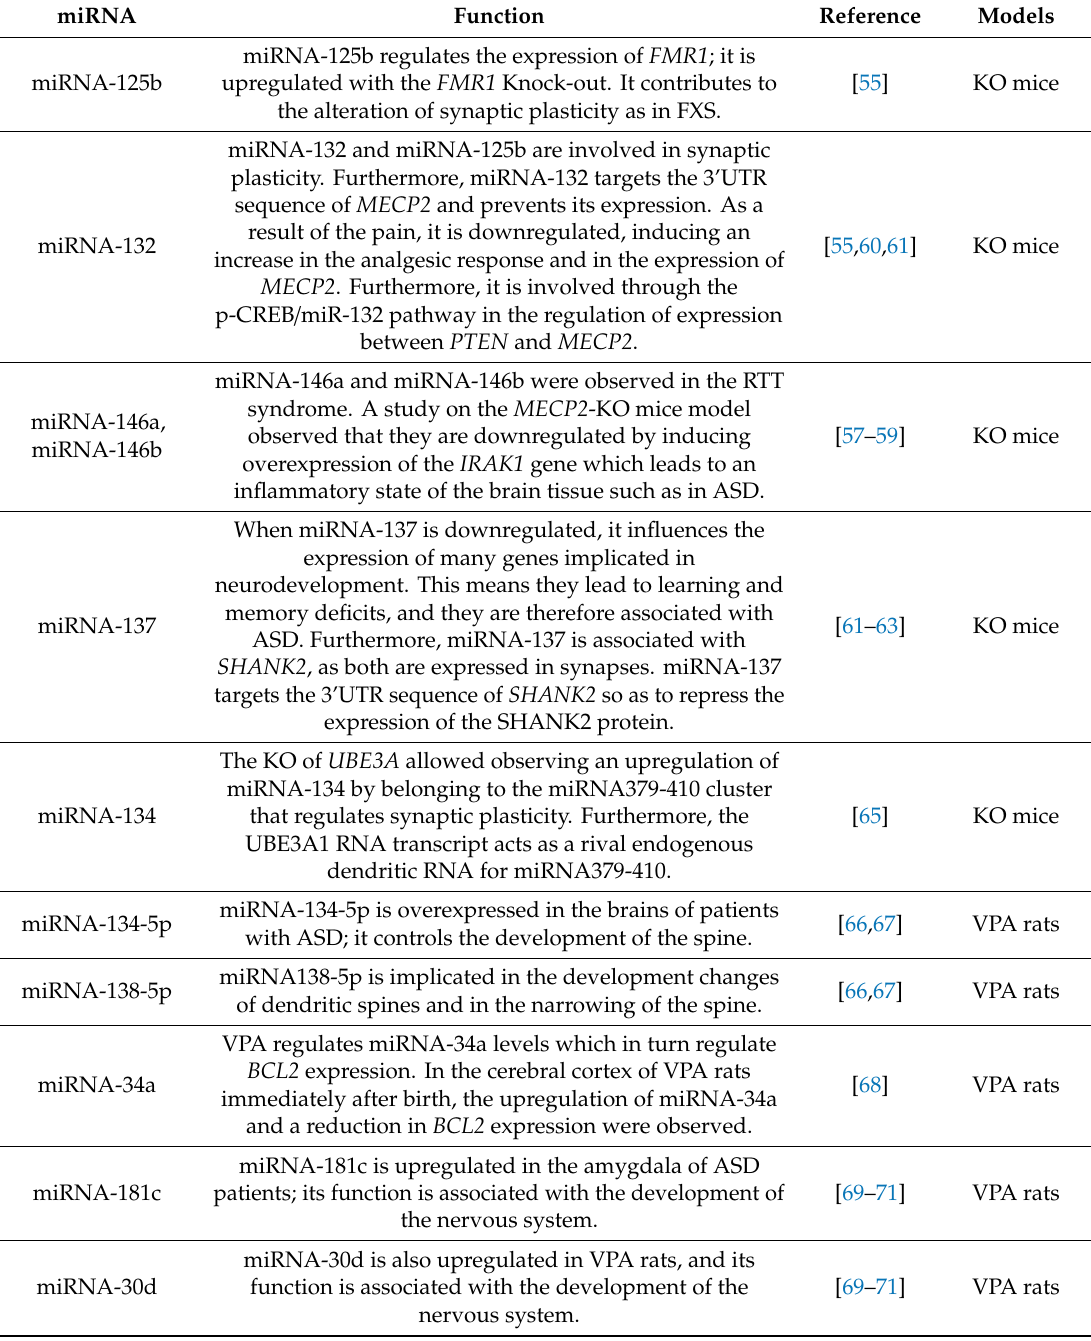
Table 2. MiRNAs dysregulated in ASD and identified in animal